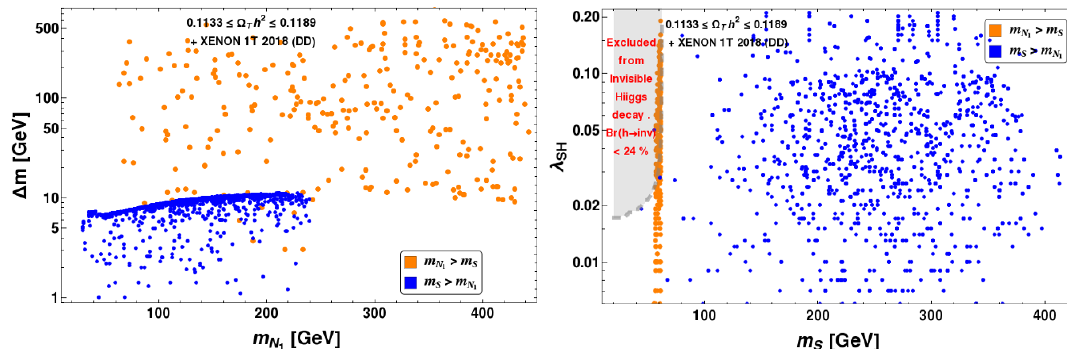
Figure 12 . Relic density and direct search (XENON 1T data [10]) allowed parameter space is shown for both N 1 and S components in m N (cid:1) m (left) and m S (cid:21) SH (right) plane. Two 1 (cid:0) (cid:0) possible mass hierarchies: m N > m S (orange points) and m S > m N (blue points) are indicated 1 1 in both planes. Invisible Higgs branching constraint is also shown in the right panel which discards a signi(cid:12)cant part of m S < m h = 2